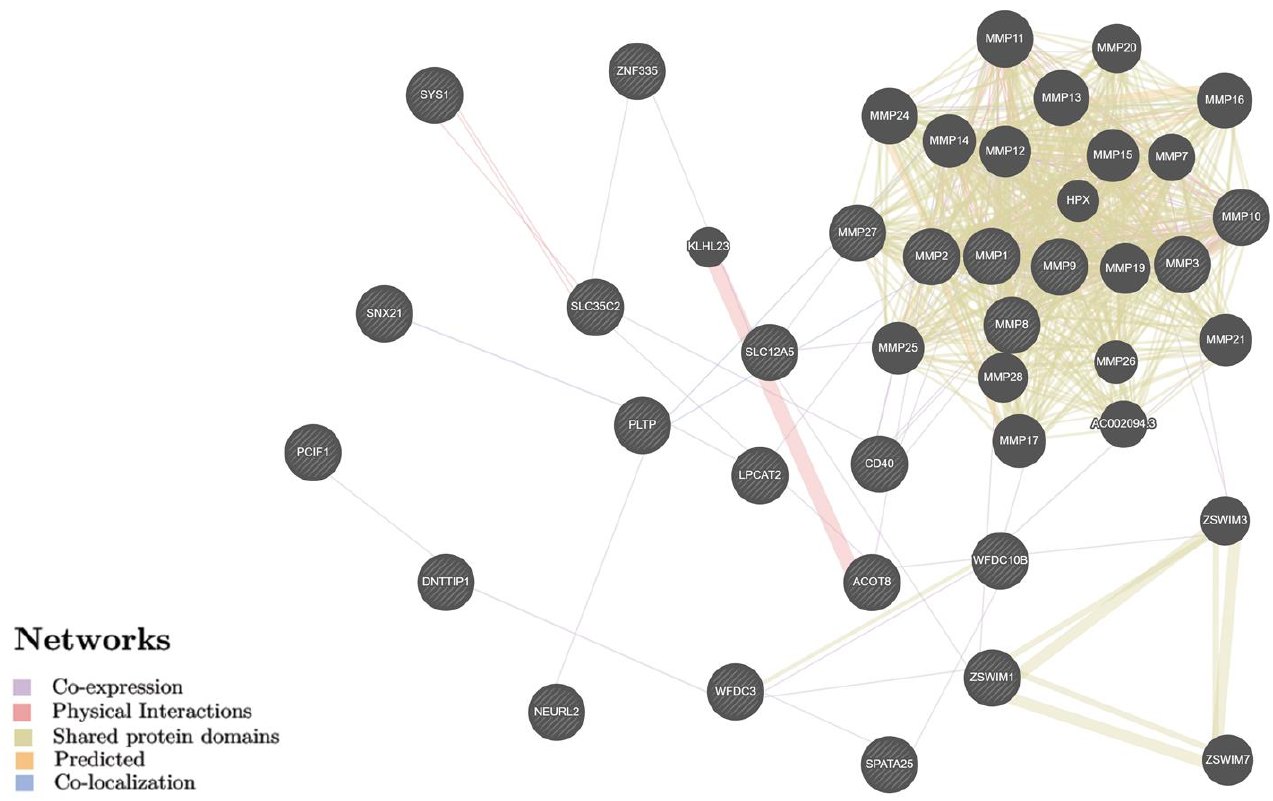
Figure 2. The interaction networks of the candidate genes for breast cancer in various tissues/organs inferred using GeneMANIA (http://genemania.org, accessed on 18 June 2022). The candidate genes are cross-shaded.